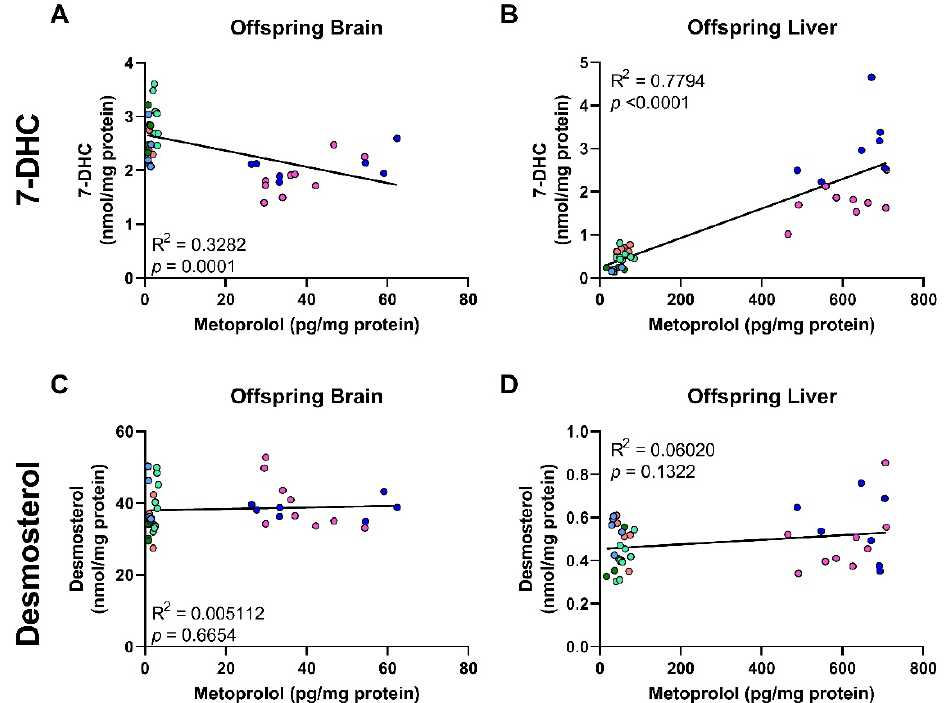
Figure 8. Metoprolol levels are correlated with 7-DHC levels ( A , B ) and DES levels ( C , D ) in the tissues of maternally exposed offspring. Only results obtained from MTP-exposed offspring are plotted. Each symbol corresponds to a single offspring sample, and samples from littermates are denoted by the same color. Lines denote simple linear regression. Note the variability between litters, but consistency within littermates.